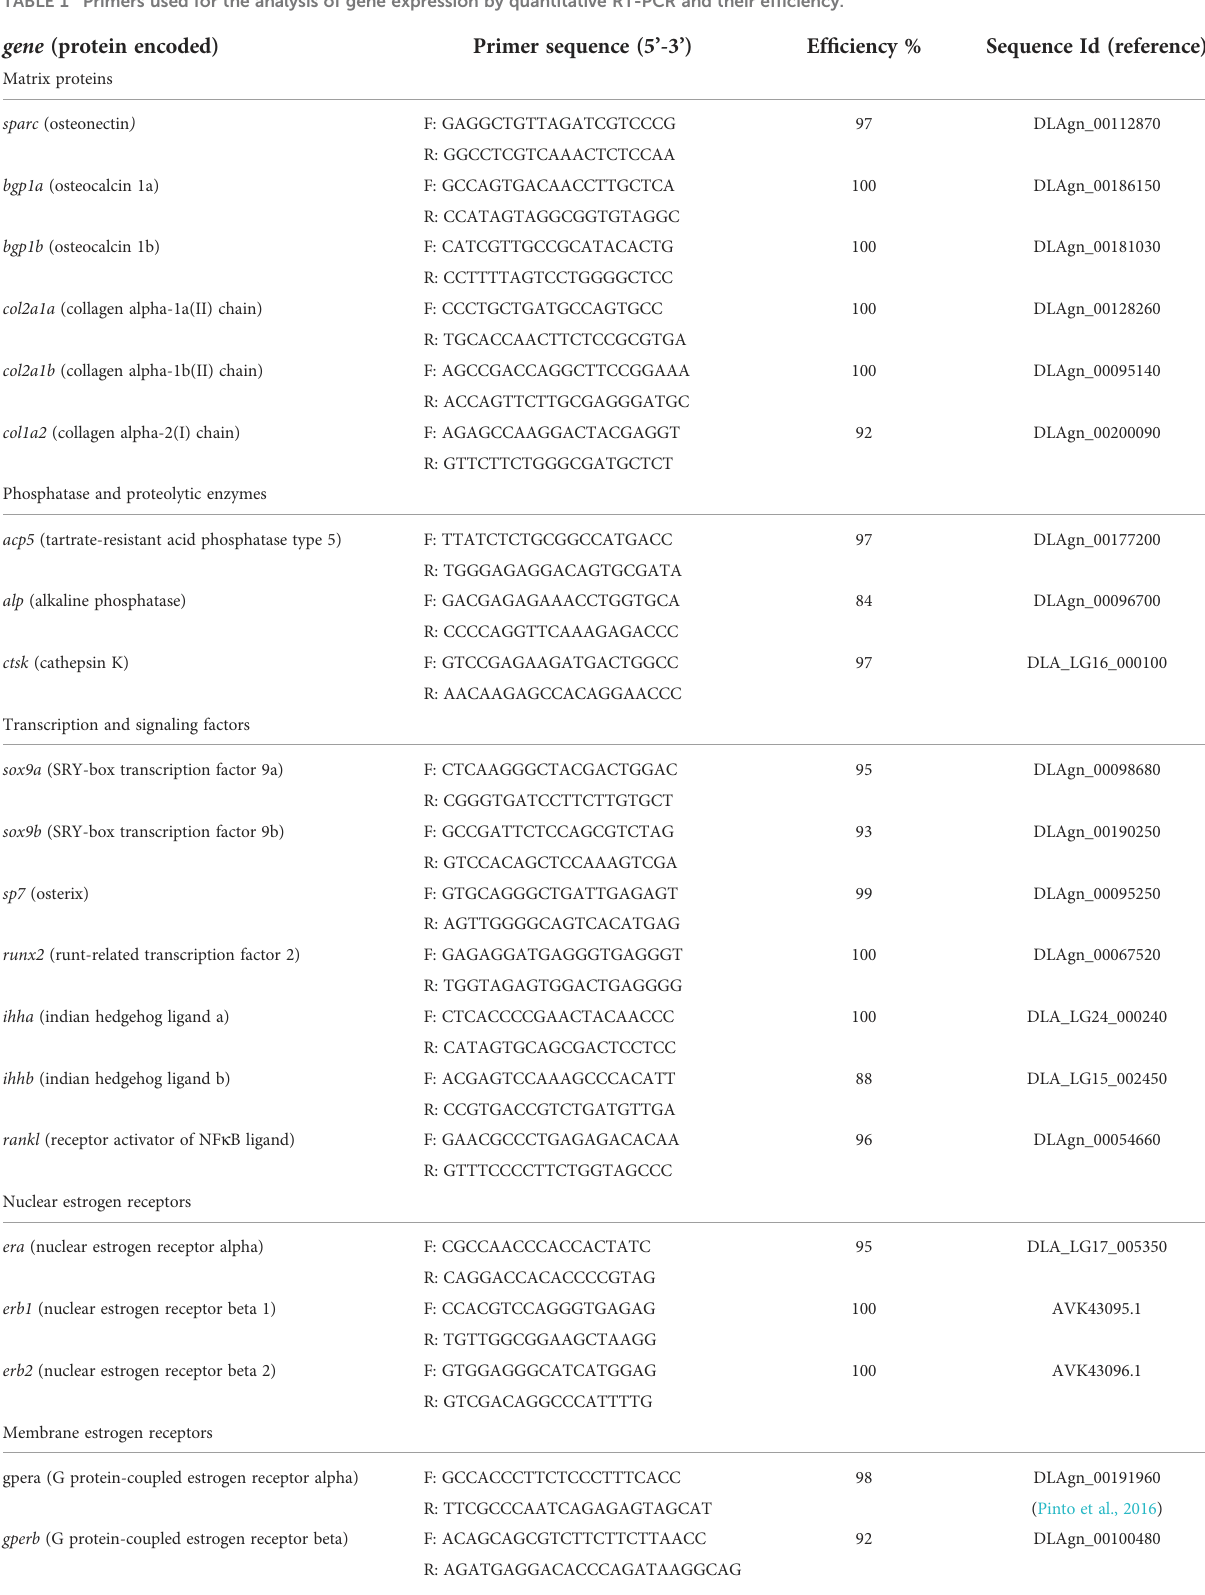
TABLE 1 Primers used for the analysis of gene expression by quantitative RT-PCR and their ef fi ciency. gene (protein